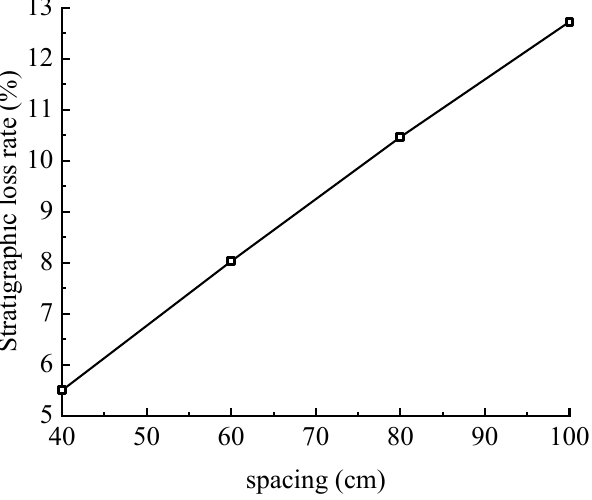
Figure 12. Relation curve between circumferential spacing and formation loss rate.